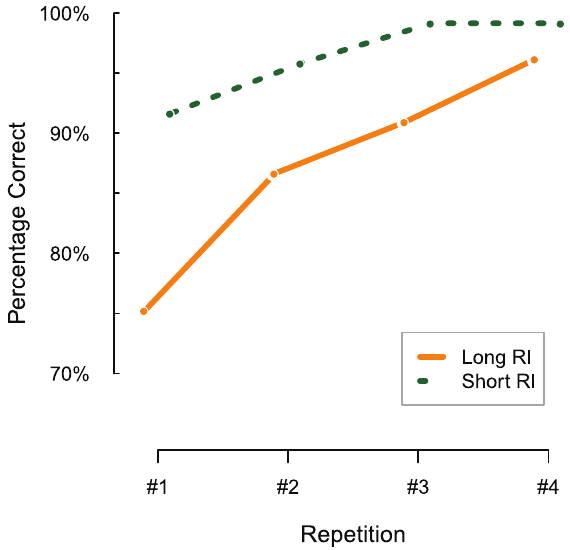
Figure 3. Percentage correct responses for the four repetitions, plotted separately for the long (orange, solid) and short (green, dashed) retention interval (RI) sets.